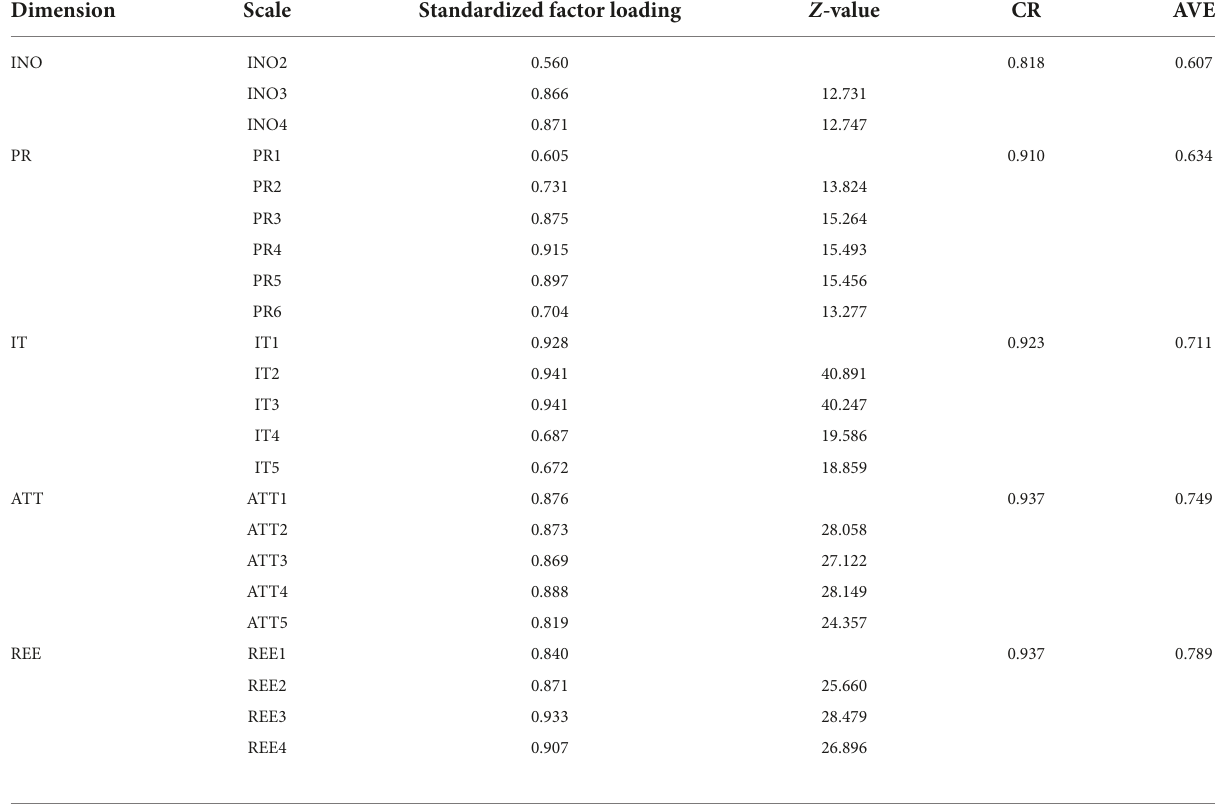
TABLE 4 Reliability and convergent validity.